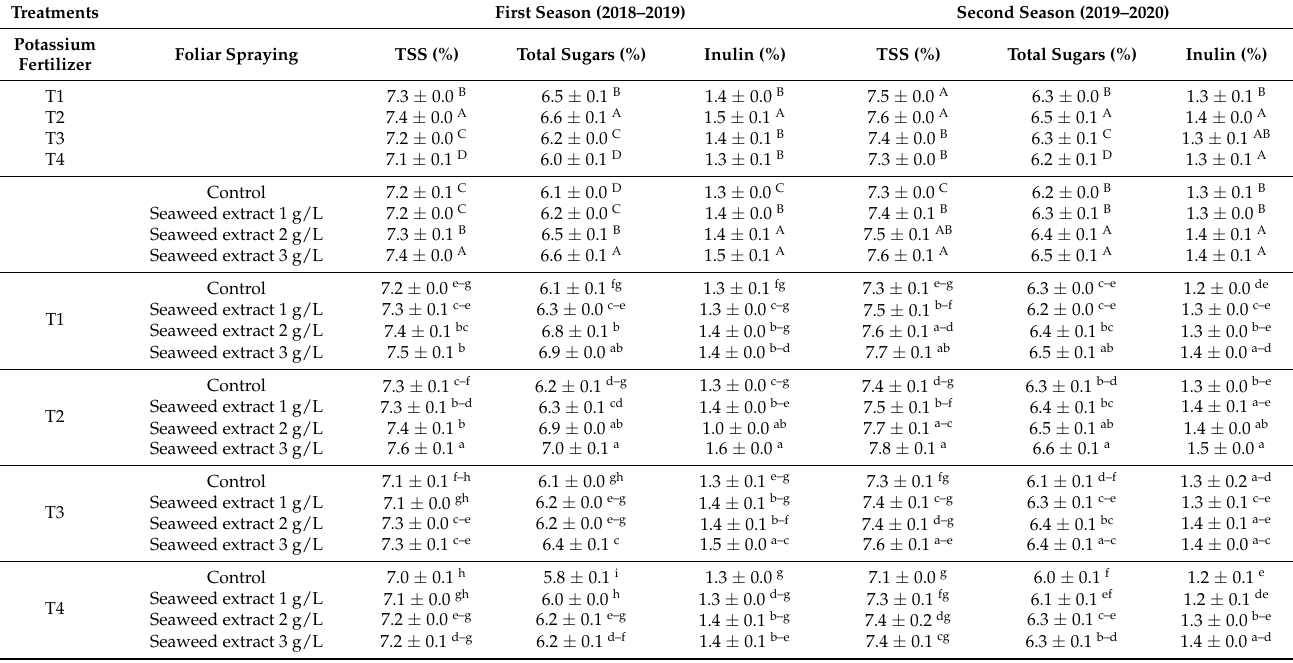
Table 8. The effect of potassium fertilizer, biofertilizer, and foliar spraying of seaweed extract on total soluble solids, total sugars, and inulin content of globe artichoke